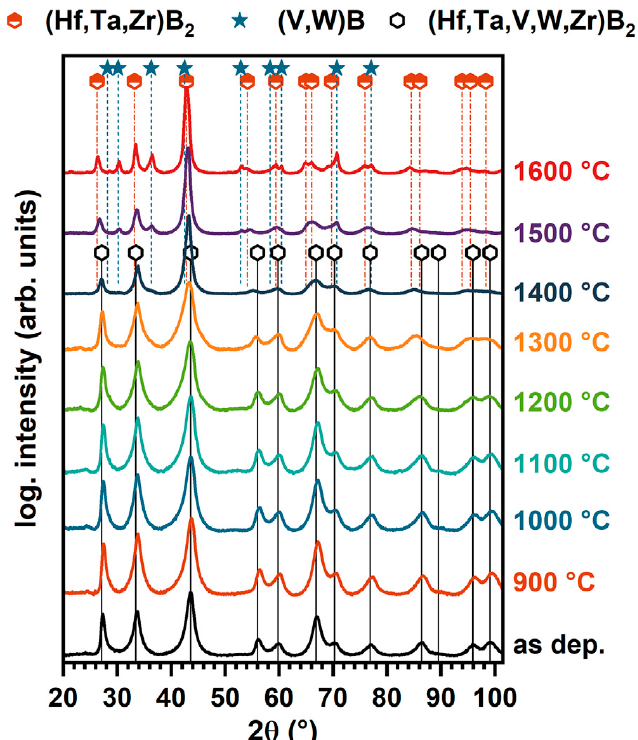
Figure 7 . X-ray diffraction patterns of vacuum-annealed (HfTaVWZr)B 2 at different temperatures. Figure reproduced with permission [98]. Copyright 2020 Acta Materialia.